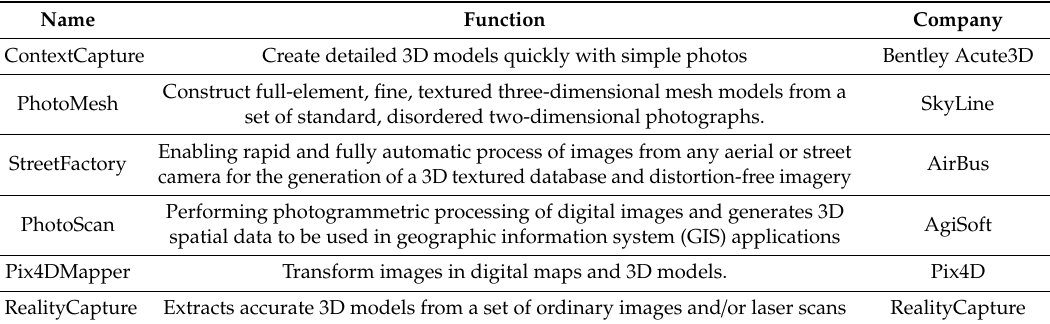
Table 3. Commercial software for 3D scene modeling utilizing